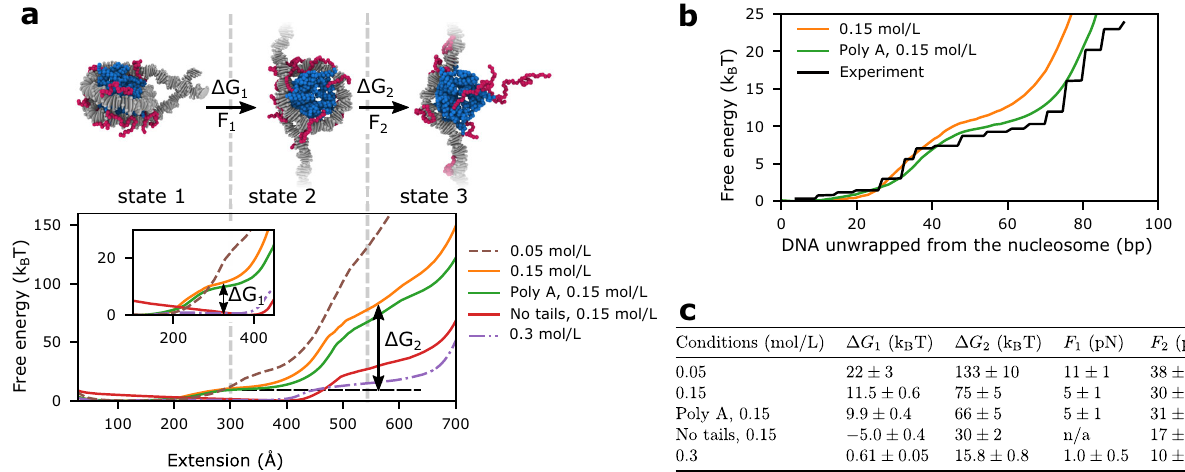
Fig. 2 Validation of chemically-speci fi c coarse-grained model against force spectroscopy experiments. a Model predictions for the force-induced unwrapping of nucleosomes under varying conditions. Top: Representative simulation snapshots of nucleosome con fi gurations (color-coded as in Fig. 1 — level 2) at three different stages of the unwrapping process, showing a fully wrapped nucleosome (state 1) at low pulling forces ( ≤ F 1 in Table in c ), a nucleosome with the fi rst turn unwrapped (state 2) at intermediate forces ( F 1 – F 2 in Table in c ), and a fully unwrapped nucleosome (state 3) at higher forces ( ≥ F 2 in Table in c ). F 1 is the maximum force during the state 1 to state 2 transition, F 2 is the maximum force during the state 2 to state 3 transition. Bottom: Free-energy cost in units of k B T for nucleosome unwrapping as measured by the PMF as a function of the end-to-end DNA distance (or extension) measured in Angstroms ( Å ). The dashed brown, solid orange, and dashed purple curves correspond to 1KX5-nucleosome 7 simulations at 0.05, 0.15, and 0.3 mol/L of NaCl, respectively. The green curve corresponds to simulations of a polyA nucleosome at 0.15 mol/L NaCl. The red curve was calculated for a nucleosome with all histone tails clipped at 0.15 mol/L NaCl. The inset provides a zoomed-in view of the low-force regime and indicates the free-energy difference between states 1 and 2 ( Δ G 1 ) for the simulations of 1KX5 nucleosomes at 0.15 mol/L NaCl. The vertical dashed lines are used as visual aids to guide the reader to the approximate regions on the PMF that exhibit different states of nucleosome unwrapping. The horizontal dashed line highlights the free-energy plateau corresponding to the transition between states 1 and 2 of the 1KX5 nucleosomes at 0.15 mol/L NaCl; the free-energy difference between states 2 and 3 ( Δ G 2 ) is also illustrated for this case. Δ G 1 is the free-energy difference between states 1 and 2. Δ G 2 is the free-energy difference between states 2 and 3. b Quantitative agreement between the free-energy cost of nucleosome unwrapping at single DNA base-pair resolution estimated with our simulations at 0.15 mol/L NaCl for nucleosomes with the 1KX5 sequence (orange curve) and a polyA sequence (green curve), and that derived from analysis of mechanical unzipping experiments at 0.10 mol/L NaCl and 0.5 mmol/L MgCl 2 (black curve) 119,120 . c Summary of the change in free energy (mean ± standard deviation) between nucleosome unwrapping states, and the corresponding rupture forces. n/a for no tails denotes that there is no rupture force for state 1 to state 2 transition as the free energy minimum is state 2. The values of G and F are obtained from reading off the graphs in a . and the uncertainty values come from the range of positions that these values could be read